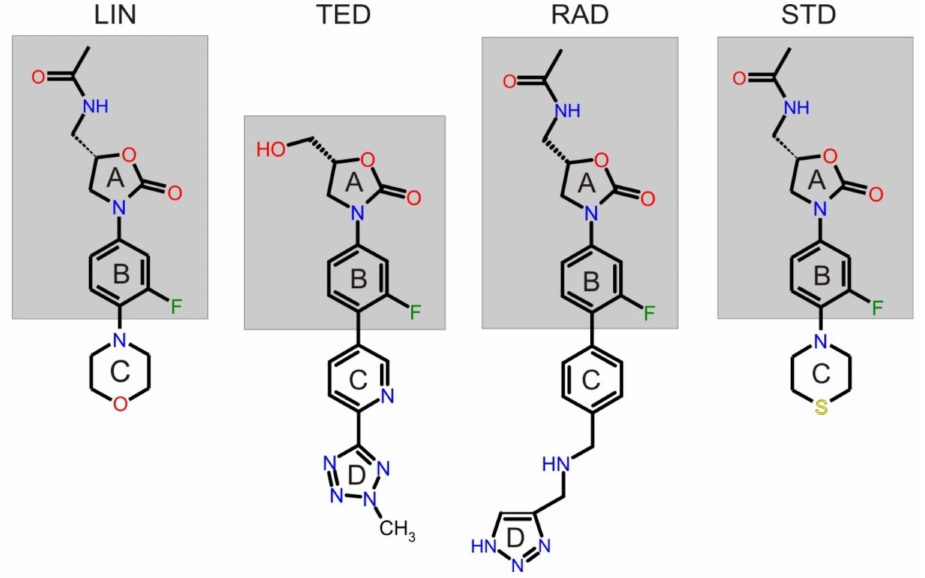
Figure 1. Molecular structures of linezolid (LIN), tedizolid (TED), radezolid (RAD), and sutezolid (STD). The LIN, TED, RAD, and STD precursors are marked in the